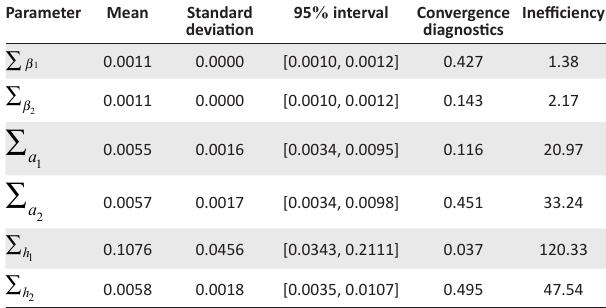
TABLE 1: Estimation results for selected parameters. Parameter